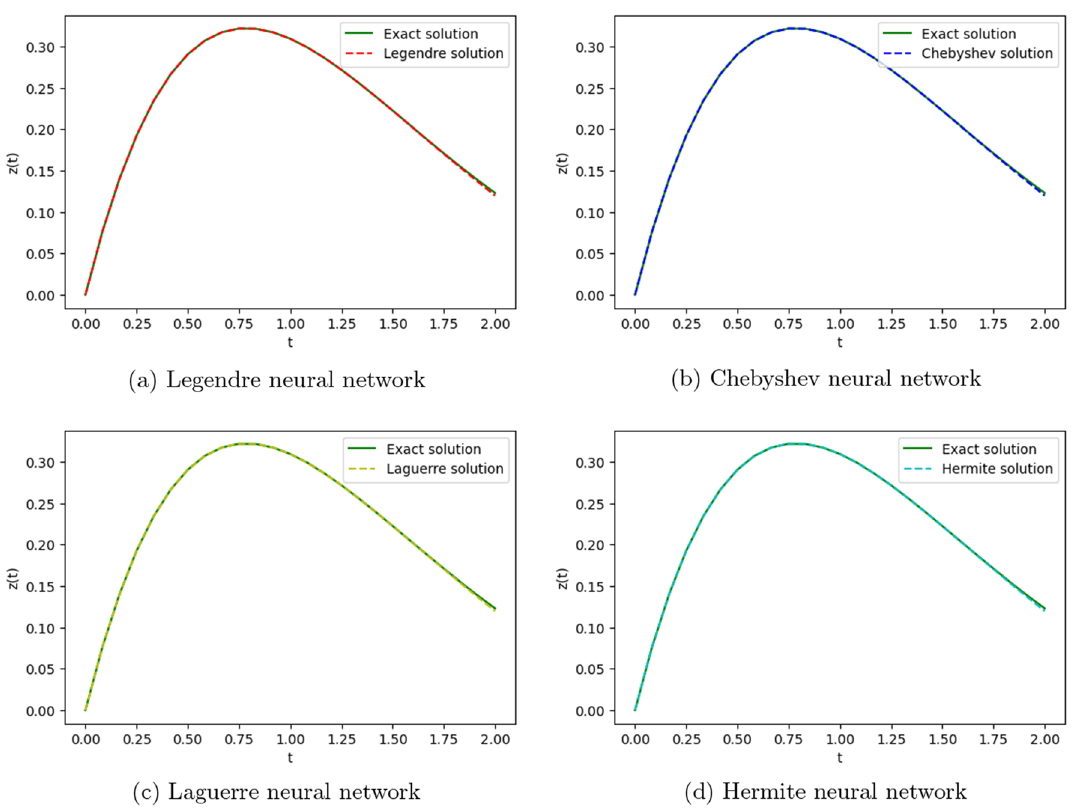
Figure 10. Comparison of the exact solution with the obtained approximate solutions of Example